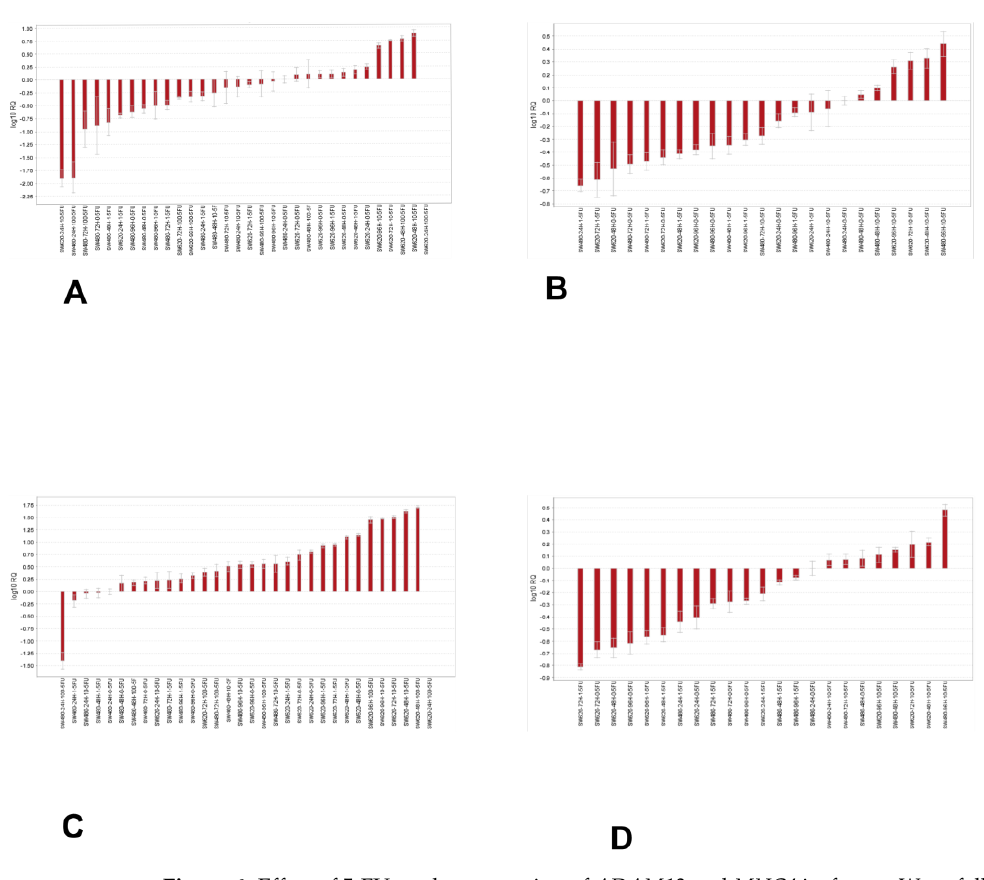
Figure 6. Effect of 5-FU on the expression of ADAM12 and MUC4 isoforms. Waterfall plots for SW480 and SW620 cells treated with 0, 1, 10 or 100 µ M 5-FU for 24, 48, 72 or 96 h. The expression of isoforms detected by the primers for ( A ) ADAM12 -All, ( B ) ADAM12-245 , ( C ) MUC4 -All and ( D ) MUC4-4 .